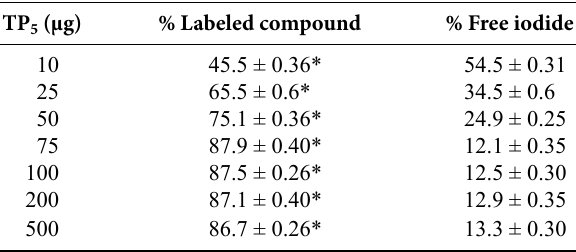
Table 3. Effect of TP 5 amount on the % labeling yield of 125 I- TP 5 TP 5 (μg) % Labeled compound